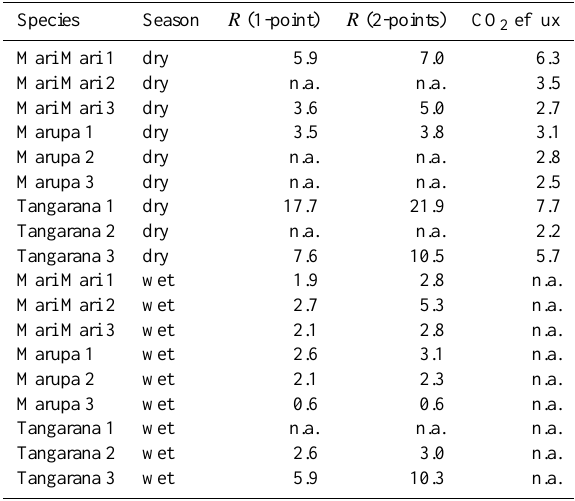
Table 5. Stem respiration rate ( R ) based on O 2 (1-point and 2-point approaches) and CO 2 efflux (dynamic chamber). The units for all columns are µmolm − 2 s − 1